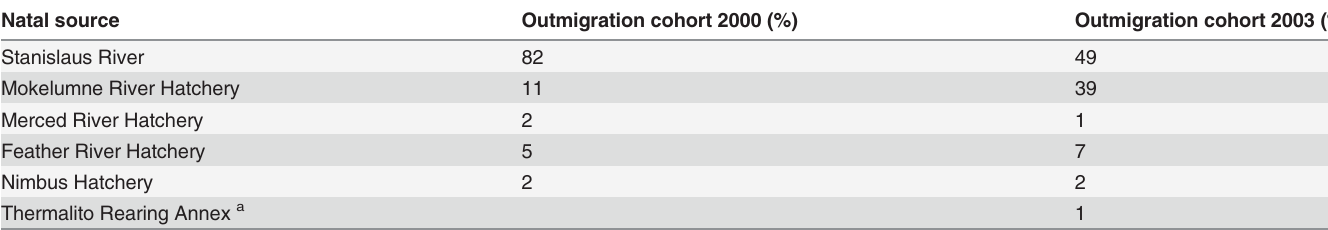
Table 3. Natal assignments of unmarked adults based on otolith 87 Sr/ 86